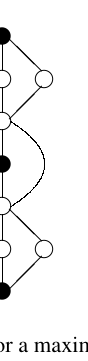
Fig. 19: Fixing v 5 for a maximum backbone tree of type 1 in case [2 . 2]